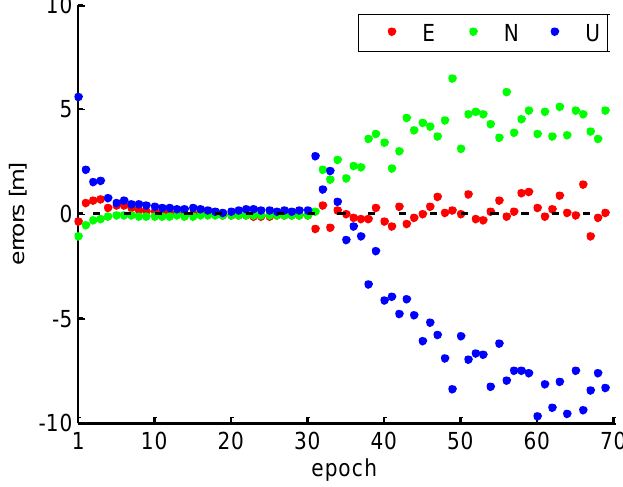
Figure 10. Conventional PPP solutions in 180 s intervals.